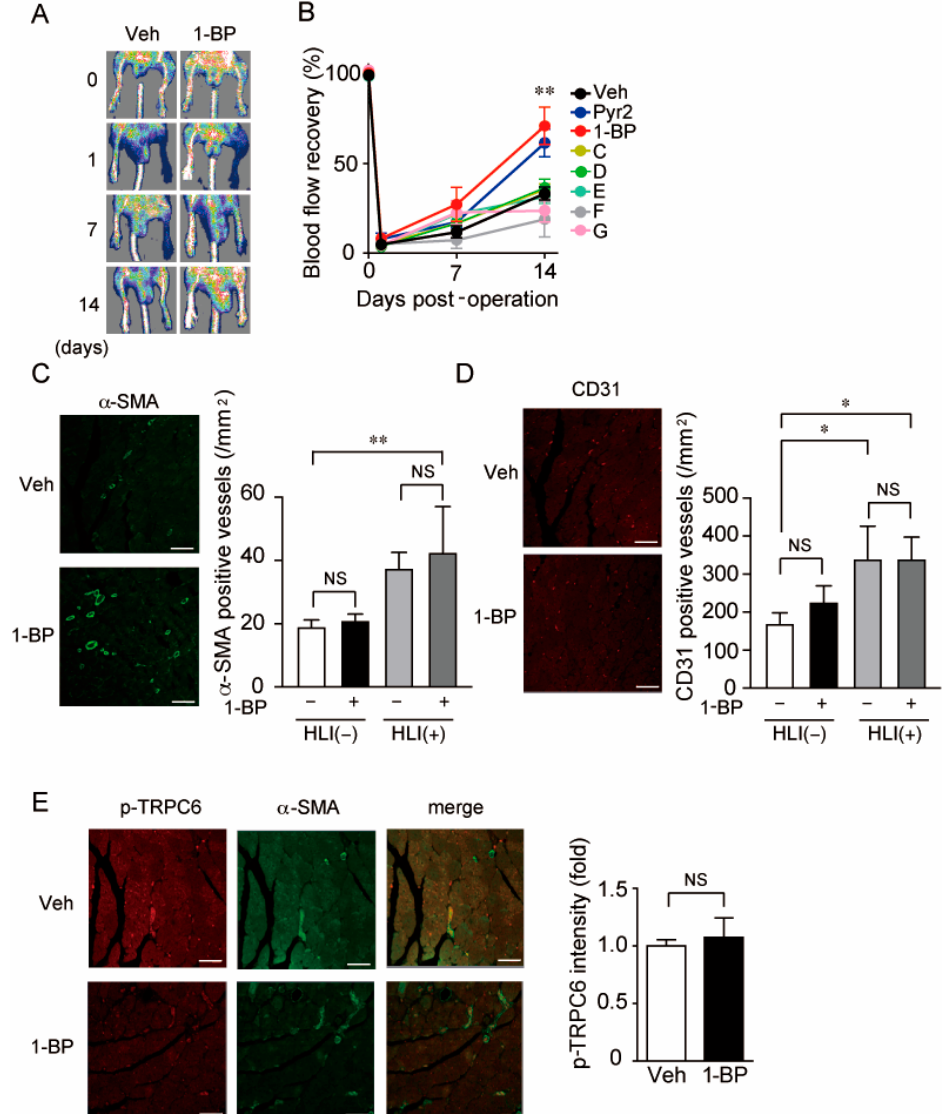
Figure 5. 1-BP ameliorates peripheral circulation through promoting arteriogenesis after HLI. ( A , B ) Representative Laser Doppler images ( A ) and averaged time courses of blood flow recovery ( B ) after HLI in mice treated with seven compounds or vehicle (Veh). Osmotic pump including the respective compound (0.1 mg/kg/day) was implanted 1 day before HLI (n = 8 mice). ( C ) Representative immunohistochemical images of α -SMA in non-ischemic and ischemic gastrocnemii 2 weeks after HLI (left). The number of α -SMA-positive blood vessels in gastrocnemii (right) (n = 3 mice). Scale bars: 50 µ m. ( D ) Representative immunohistochemical images of CD31 (left). The number of CD31- positive blood vessels in gastrocnemii (right) (n = 3 mice). Scale bars: 20 µ m. ( E ) Representative images of Thr69-phosphorylated TRPC6 and α -SMA expressions in gastrocnemii 2 weeks after HLI (left). Quantification of phospho-TRPC6 (T69) fluorescence intensity normalized by that of α -SMA (right) (n = 3 mice). Scale bars: 50 µ m. Data are mean ± s.e.m. ( B ) or median with 95% CI (C–E). * p < 0.05, ** p < 0.01, NS.; no significance. Comparisons were made using Two-way ANOVA followed by Tukey’s multiple comparison tests ( B ), One-way ANOVA followed by Tukey’s